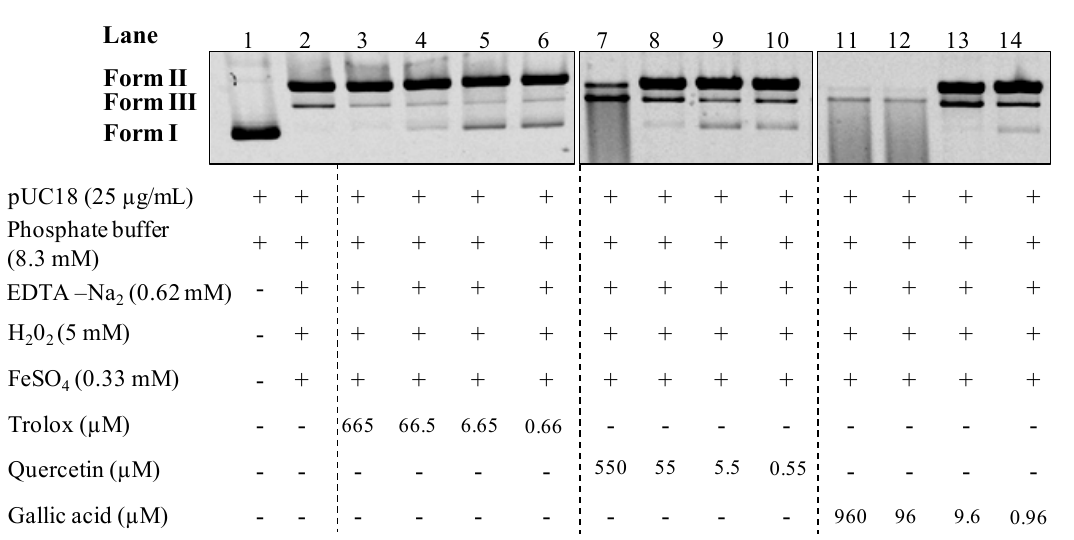
Figure 2. ( a ) Strand breaks protective capacity of aqueous trolox, quercetin and gallic